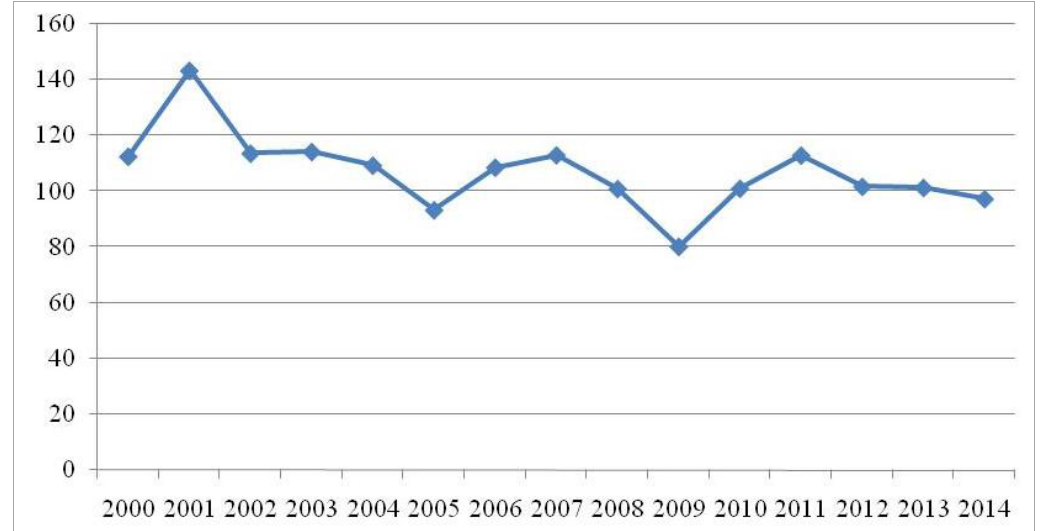
Fig. 2. Dynamics of indexes of industrial production in Lviv Region for the period of 2000-2014, expressed in percents. Calculated on the basis of the data from Main Department of Statistics of Lviv